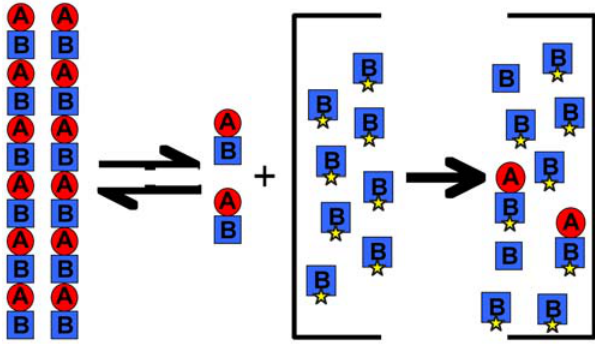
Figure 5. Between-dimer mutants disassemble wild type polymers by sequestering subunits into inactive heterodimers. The equilibrium on the left shows wild type BtubA/B protofilaments exchanging with dimers. These dimers are also exchanging with a small pool of monomers, not shown. The bracket on the right shows what happens when the reaction is flooded with between-dimer BtubB subunits. These are capable of forming dimers, and because they are in excess of the monomer/dimer pool they will replace the wild type BtubB. This sequesters most of the wild type BtubA into inactive dimers. This depletion of wild type dimers to below the critical concentration results in depolymerization.